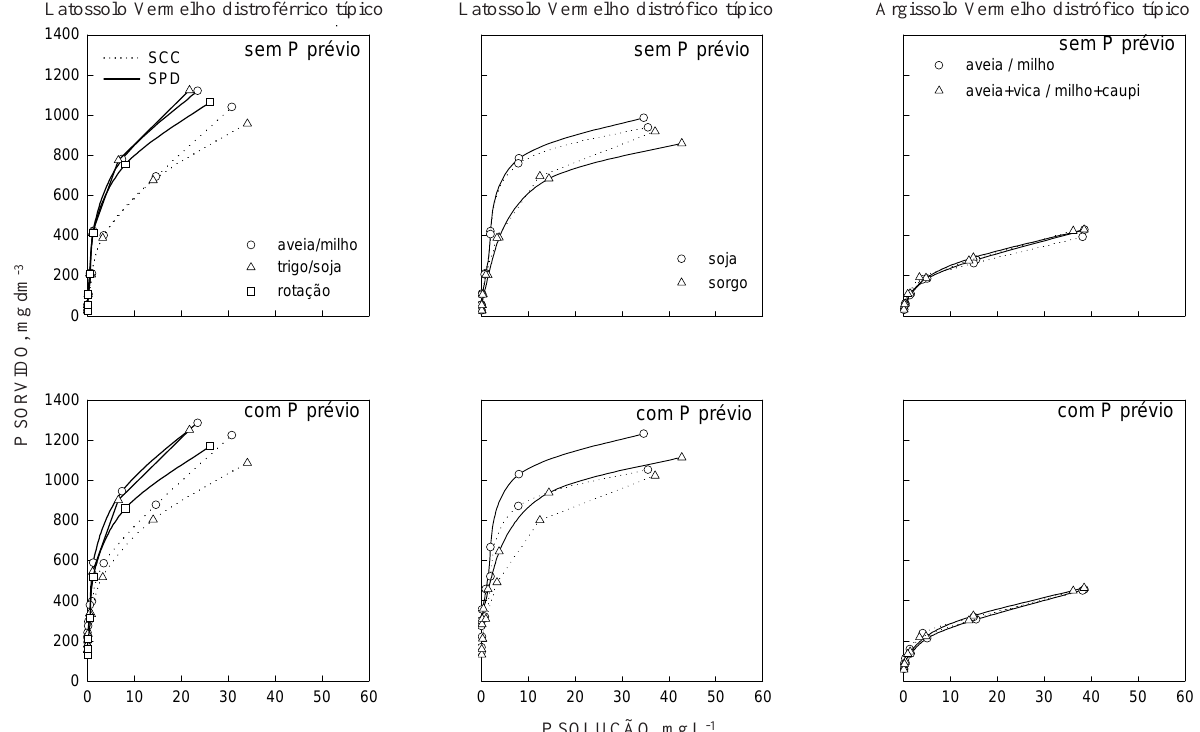
Figura 3. Relação entre o fósforo sorvido e o fósforo da solução da camada de 7,5-17,5 cm, sem e com a inclusão do fósforo previamente sorvido em diferentes solos, métodos de preparo e sucessões de culturas.